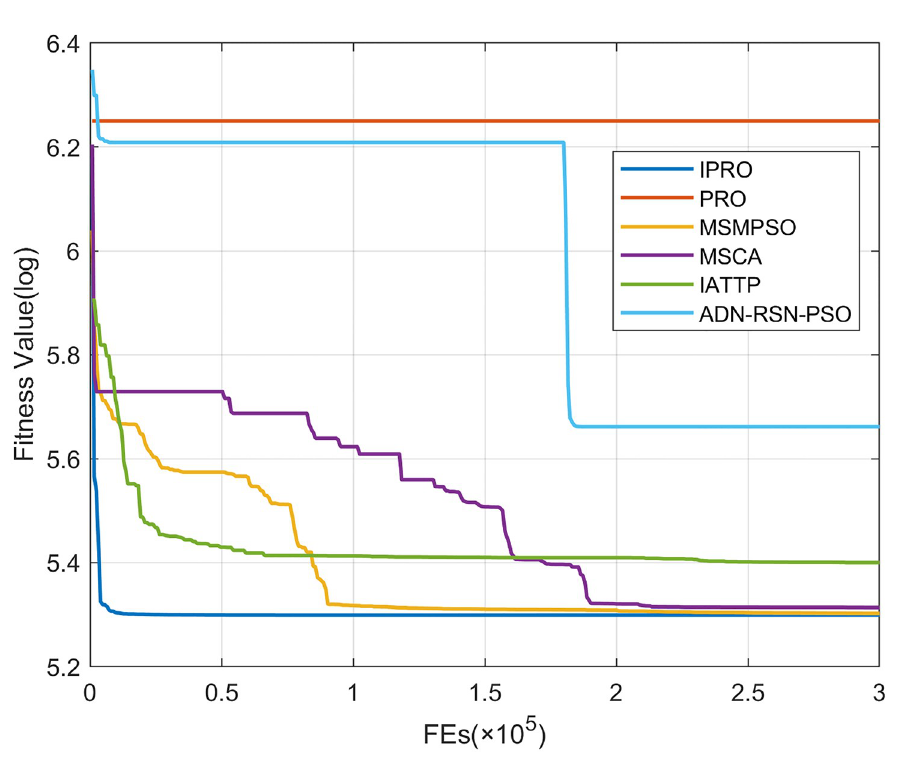
Fig 24. Convergence curves on F24.